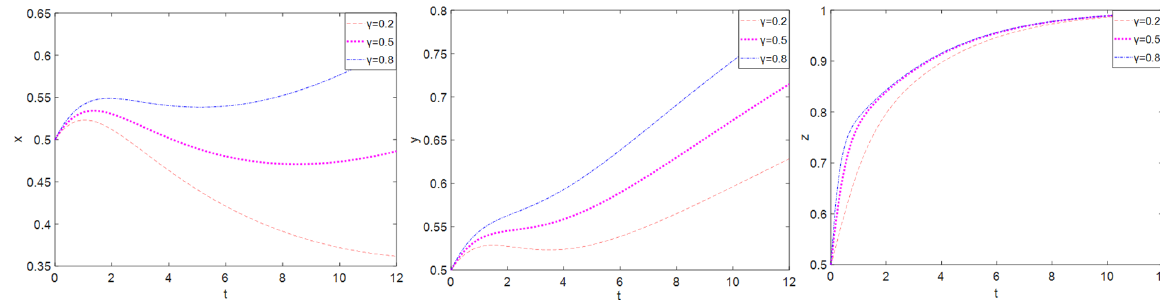
Figure 3. The impact of environmental pollution punishment on the behavior of suppliers of collab- orative innovation in green building projects of construction enterprises according to evolutionary game.